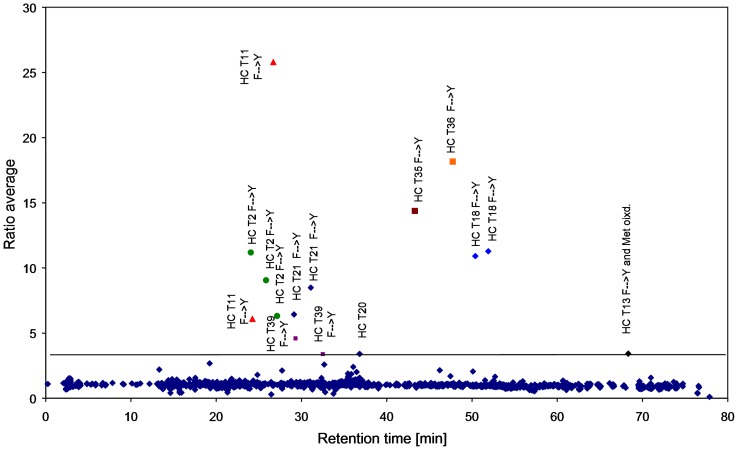
Differential analysis of mass/retention time profiles of two LC-MS/MS data set replicates from tryptic digests of recombinant human IgG1 antibody C under phenylalanine starvation versus phenylalanine supplementation conditions.The horizontal line indicates the minimal intensity ratio value above which m/z signals are considered. Peaks showing identical MS and MS/MS data but eluting at different retentions time are marked by shape and color.